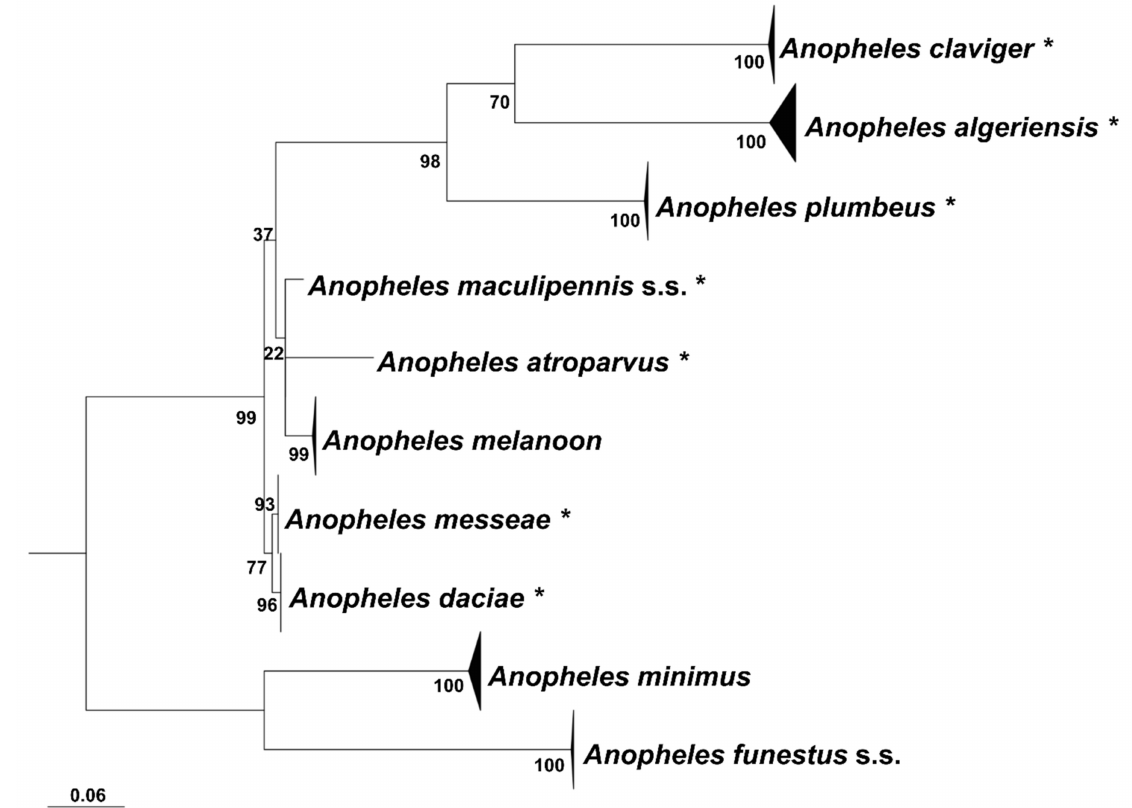
Figure 1. Condensed ITS2 ML-tree (K2P model) of five members of Anopheles maculipennis s.l. ( An. ma- culipennis s.s.; An. messeae ; An. atroparvus ; An. daciae ; An. melanoon ), four of which were collected in the Netherlands in the present study, including An. plumbeus , An. claviger and An. algeriensis occurring in the Netherlands, and An. funestus sensu stricto and An. minimus as outgroups (GenBank accession numbers: KP298399, KP298400, OK570292, OK570315). Duplicate sequences per species were excluded, with the ITS2 databases for An. messeae and An. daciae including a few sequences displaying ambiguous sites. Numbers at nodes are bootstrap support values. * species reported in the